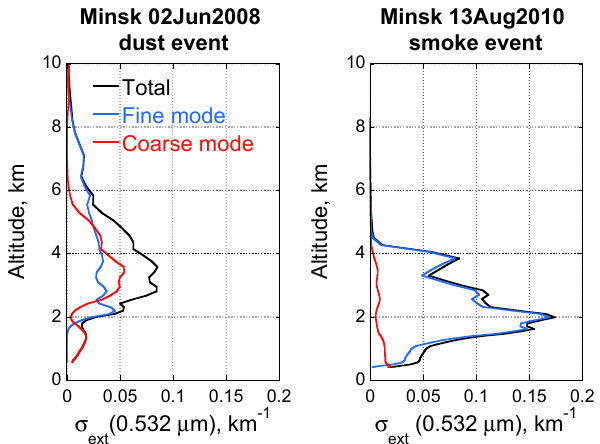
Fig. 21. Retrieved vertical profiles of aerosol extinction.